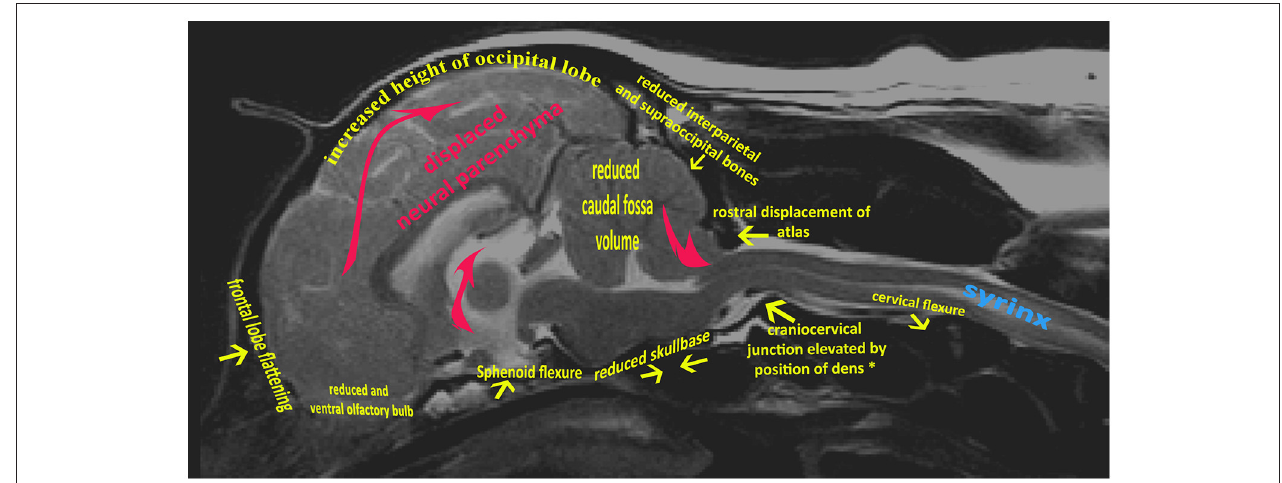
FIGURE 1 | Mid-sagittal T2-weighted image of brain and cervical spinal cord of CKCS with CM and SM. Yellow arrows indicate generalized skeletal variances from normal CKCS skull and cervical junction. Red arrows indicate displaced neural